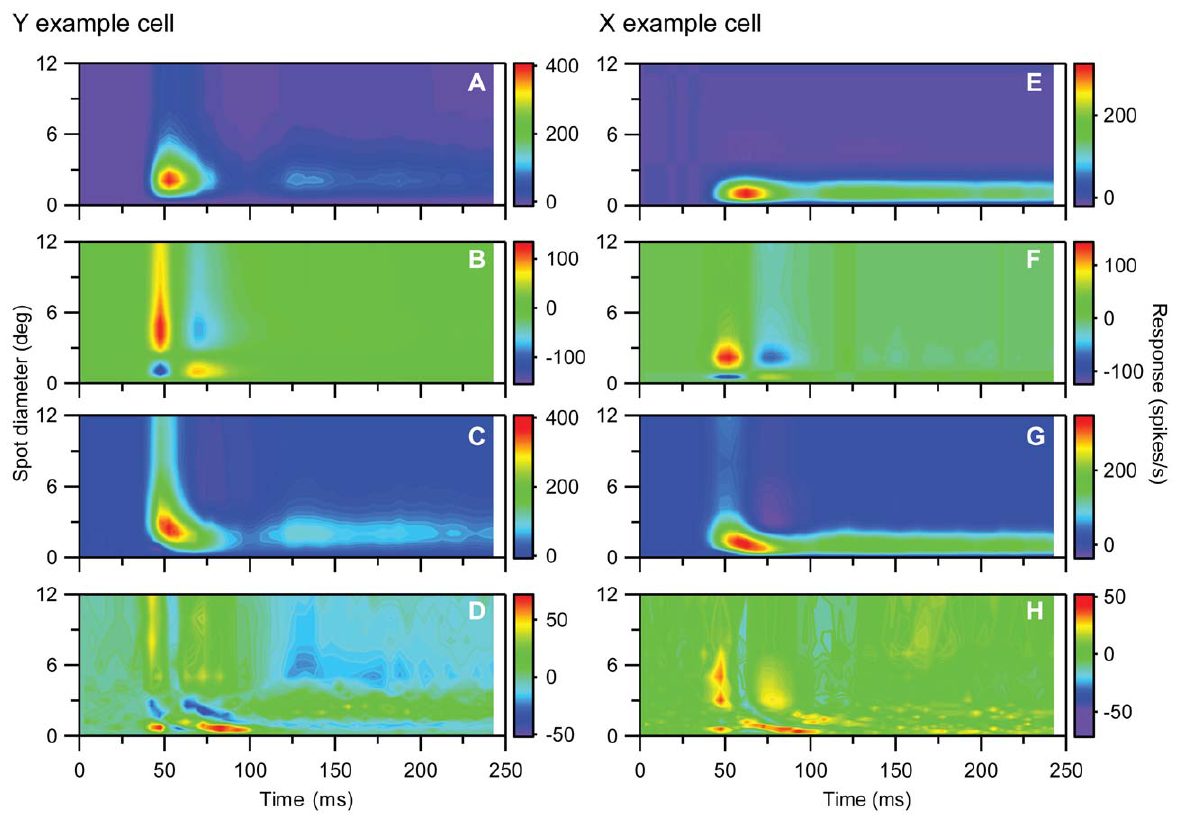
Figure 5. Principal components analysis (PCA) for example on-center Y and X neurons in Figs. 1 and 2. A , B , 1 st and 2 nd principal components, respectively, for the Y-neuron response data, i.e., contributions from terms with n=1 and n=2 in Eq. (3). C , Sum of contributions from two first principal components (and background activity) for Y neuron. D , Deviation between experimental results for Y neuron and PCA results in ( C ). Error e (cf. Eq. 1) is 0.036. E–H , Same as ( A )–( D ) for the X-neuron response data. The deviation between experimental results and PCA results ( G ) corresponds to an error e =0.015.